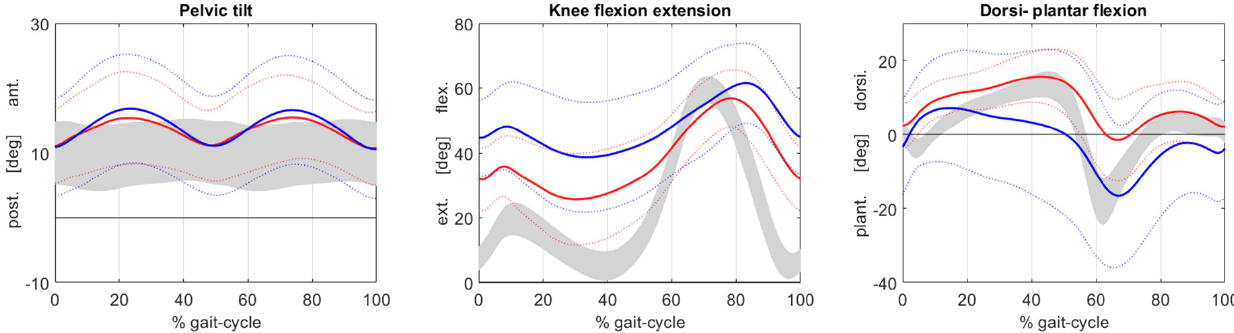
Figure 2. Sagittal plane kinematic graphs illustrating the pelvic tilt, knee flexion and extension and ankle dorsi- and plantar flexion during preoperative (E 0 : blue line) and mid-term (E 2 : red line) gait analysis. The grey areas represent gait data of an age-matched control group. The x -axis represents gait cycle in percent; y -axis marks the range of motion in degrees. Solid lines represent average values and dashed lines one standard deviation.